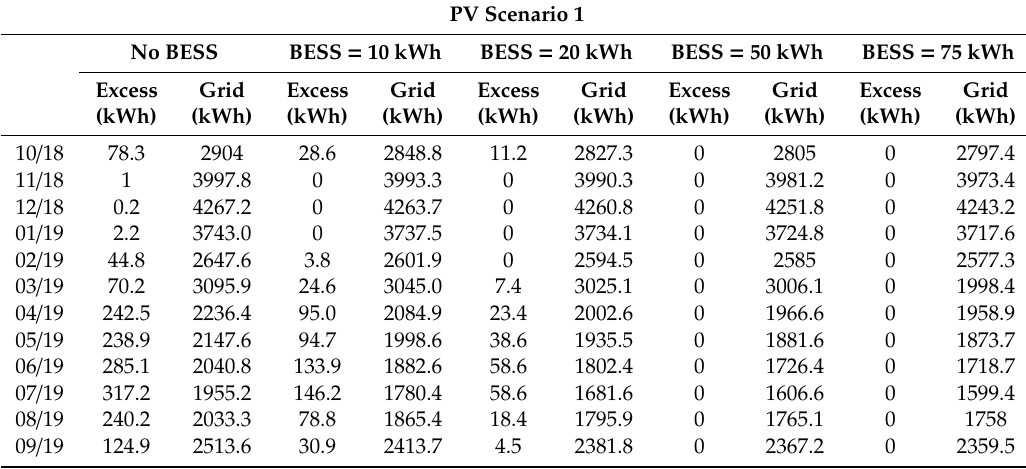
Table A1. Energy sent / taken to / from the grid considering various BESS capacities obtained for PV Scenario